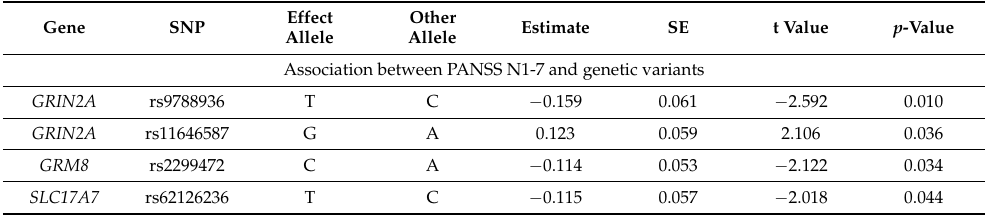
Table 4. Results of analysis of association between PANSS scores and genetic